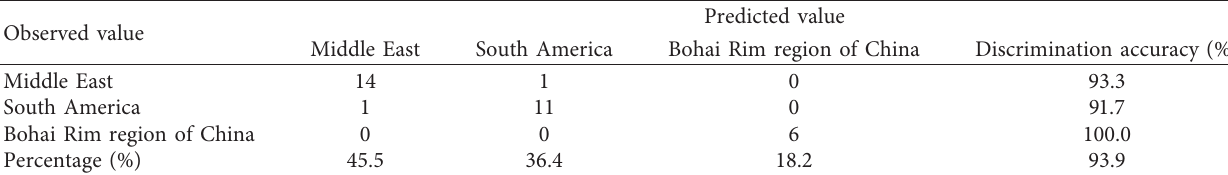
Table 9: The discrimination result of multinomial logistic